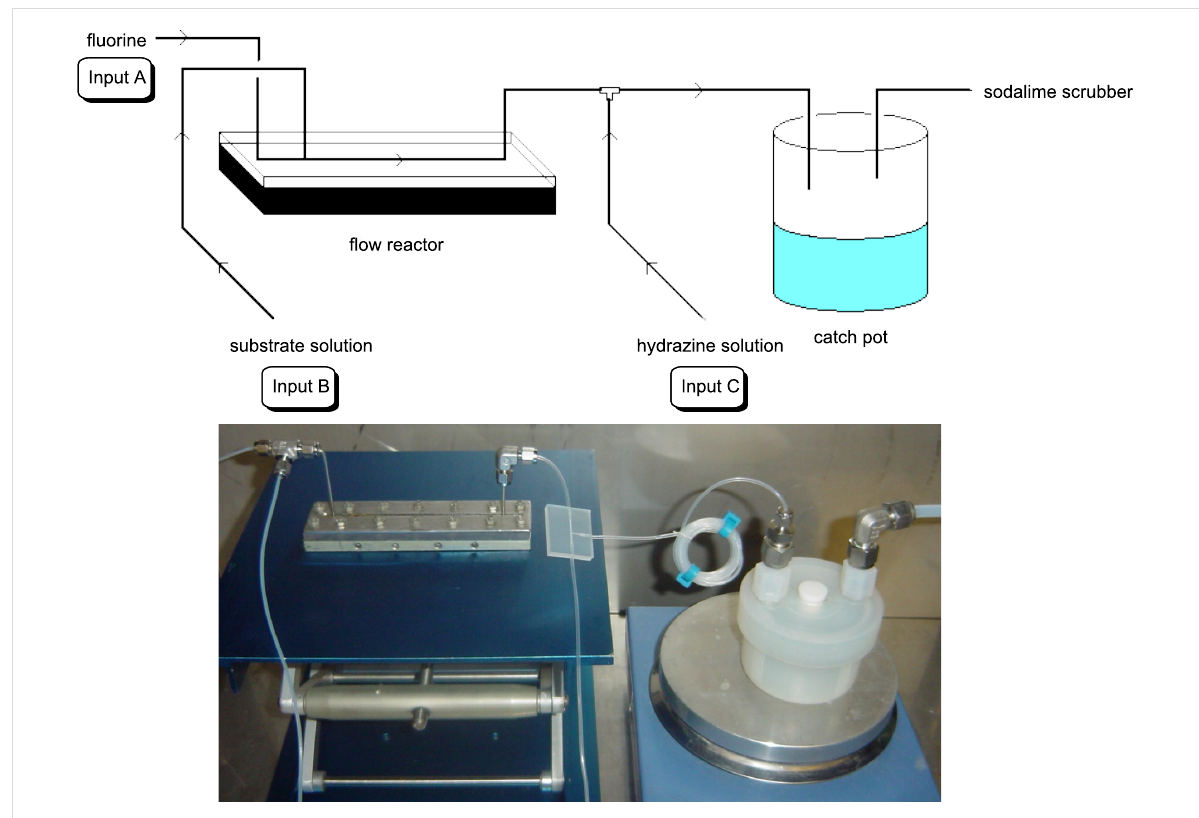
Figure 1: Sequential gas/liquid–liquid/liquid flow reactor for the synthesis of 4-fluoropyrazole derivatives.